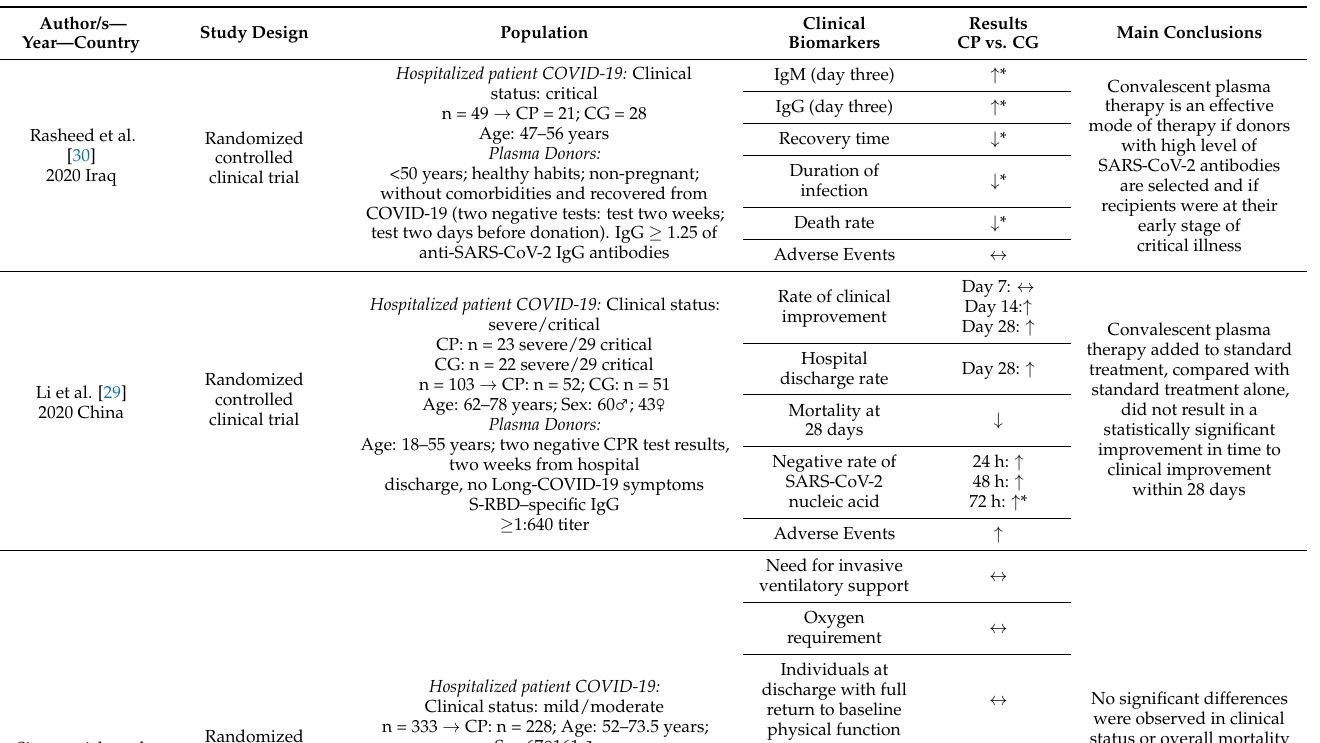
Table 3. Summary of the results of the studies included in the systematic